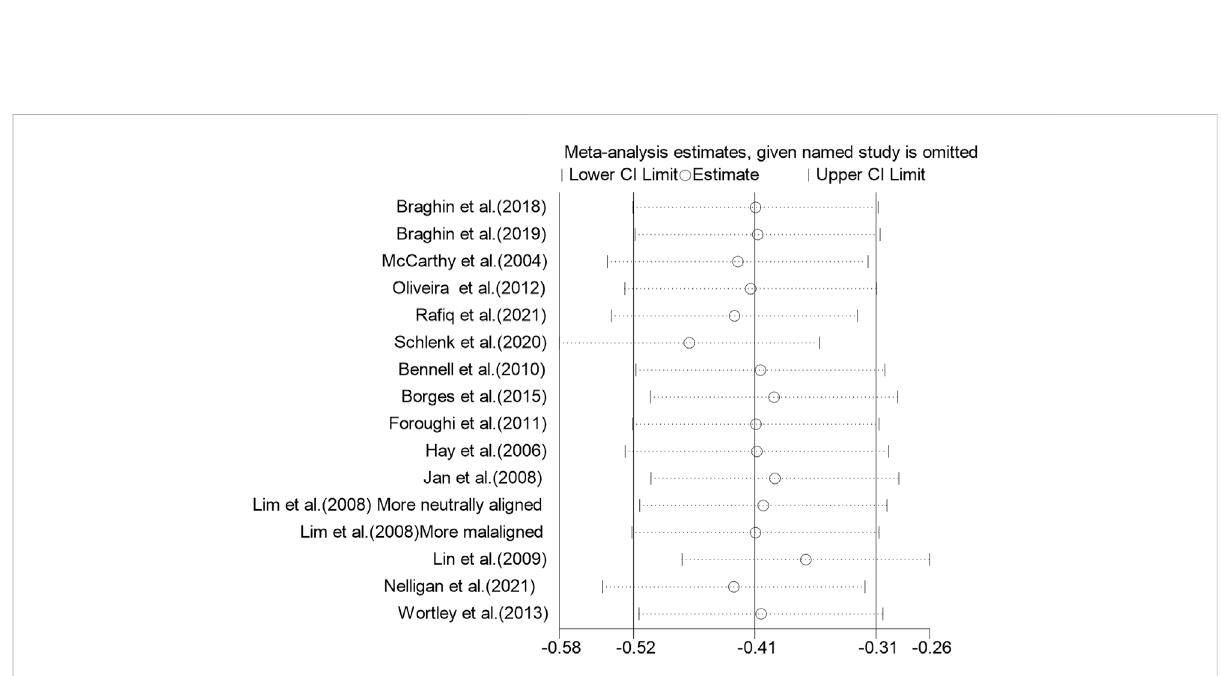
FIGURE 7 Sensitivityanalysisplot:Theliteraturedatawereeliminatedonebyone,andtheresultsshowedthatnosinglearticlehadagreaterimpactonthe